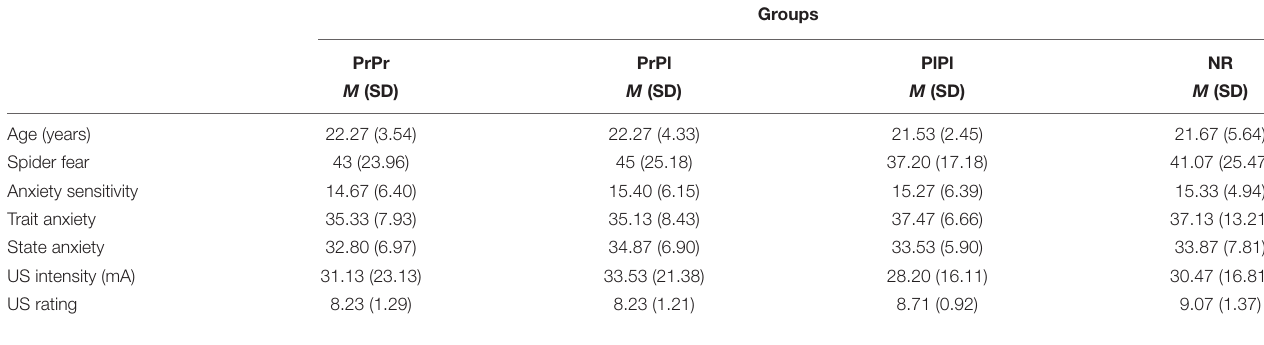
TABLE 1 | Participant characteristics per